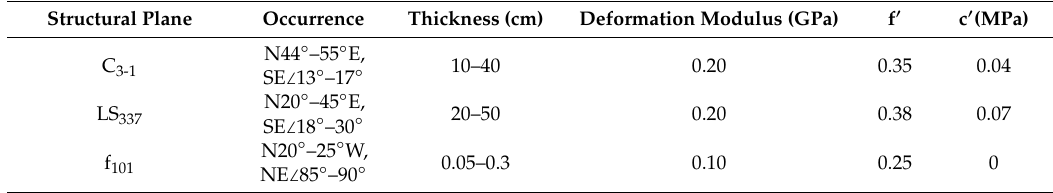
Table 1. Physical–mechanical parameters of the structural planes.